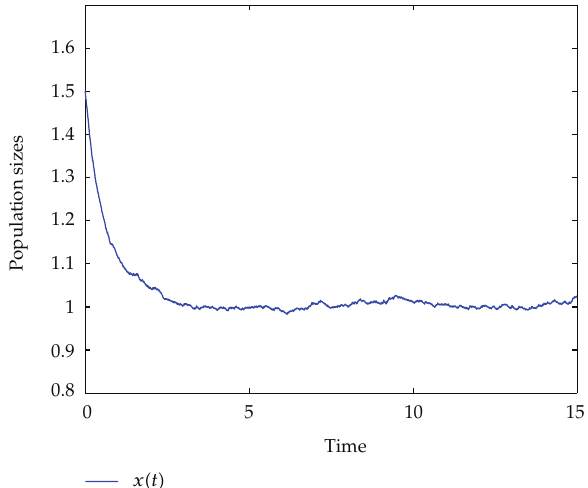
Figure 5: Global asymptotical stability of model (cid:3) 1.2 (cid:4) , step size Δ t (cid:5) 0 . 001 and x (cid:3) 0 (cid:4) (cid:5) 1 .